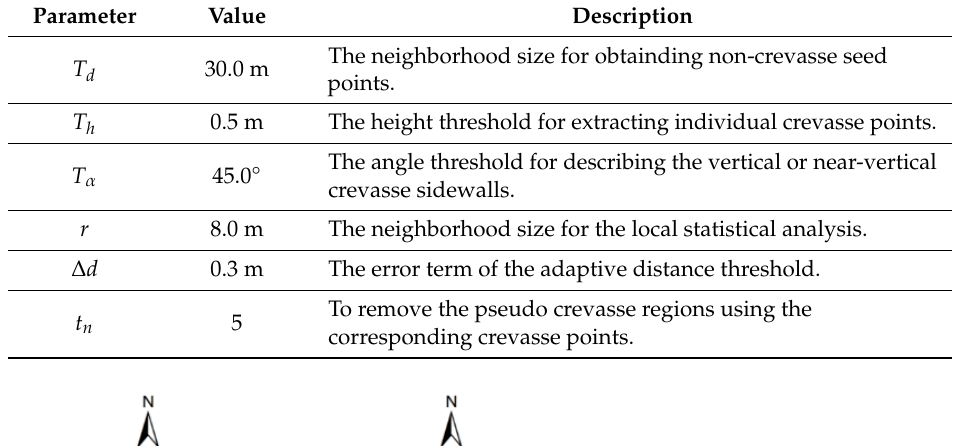
Table 2. Main parameters settings for the proposed method.